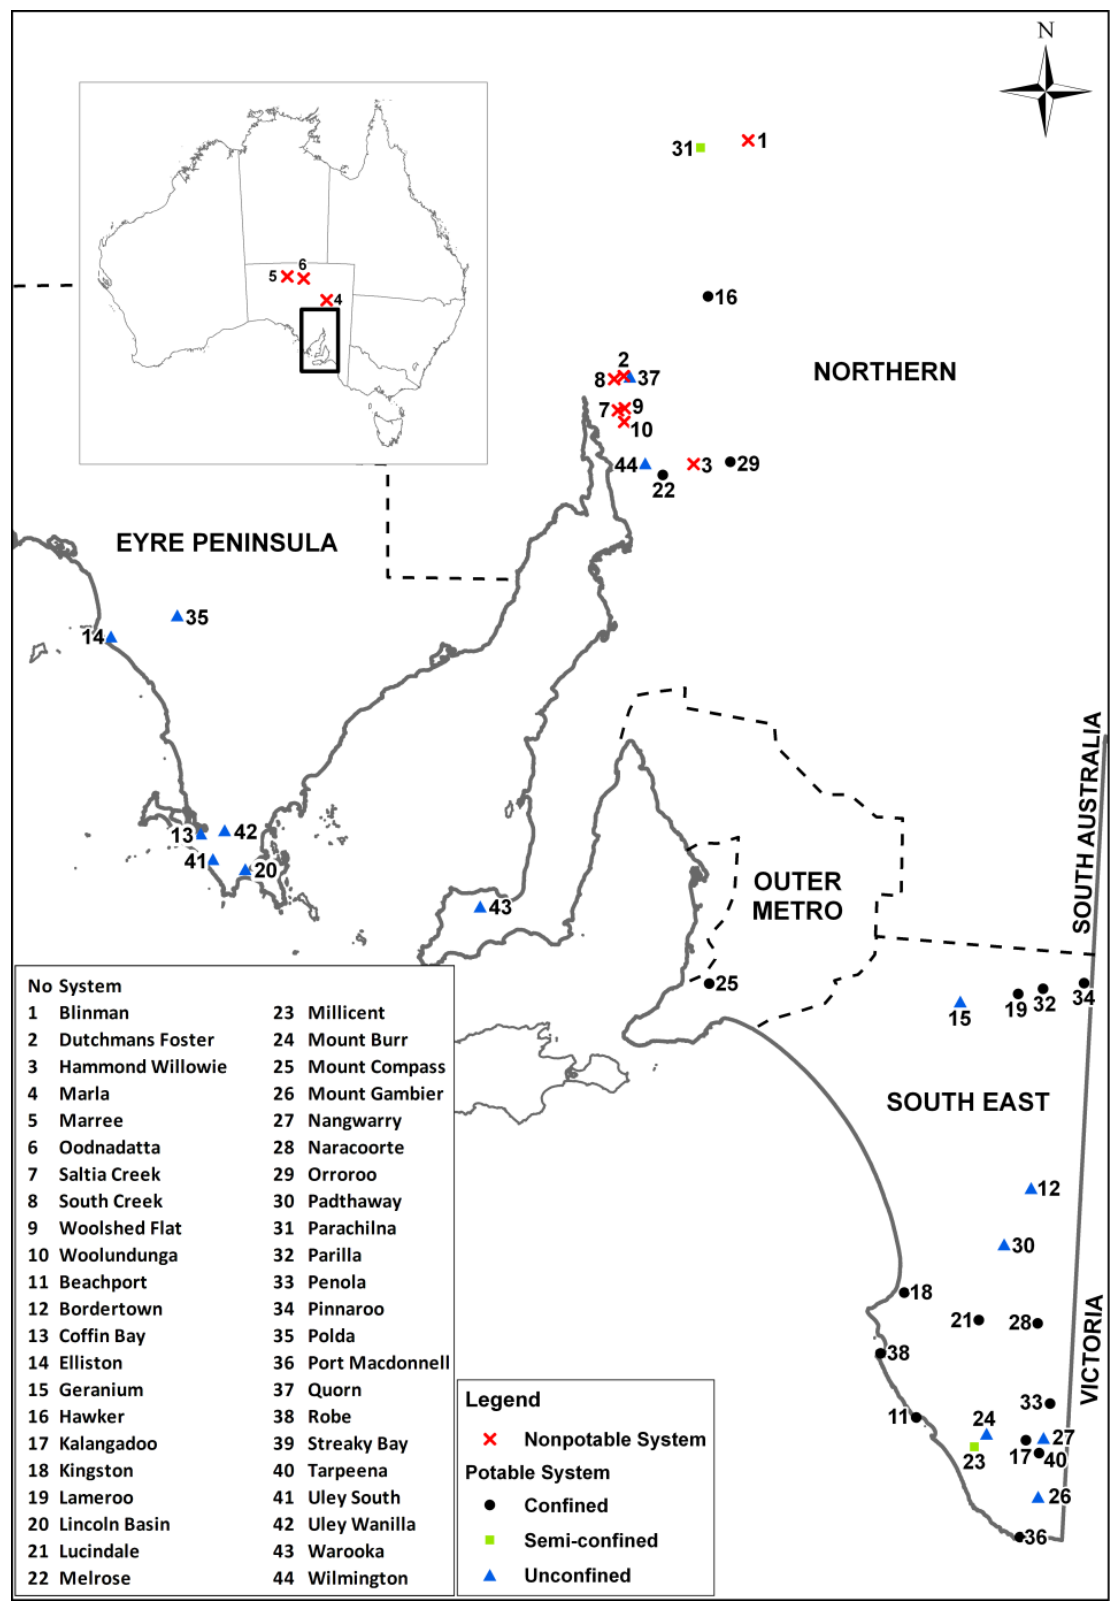
Figure 3. Groundwater supply